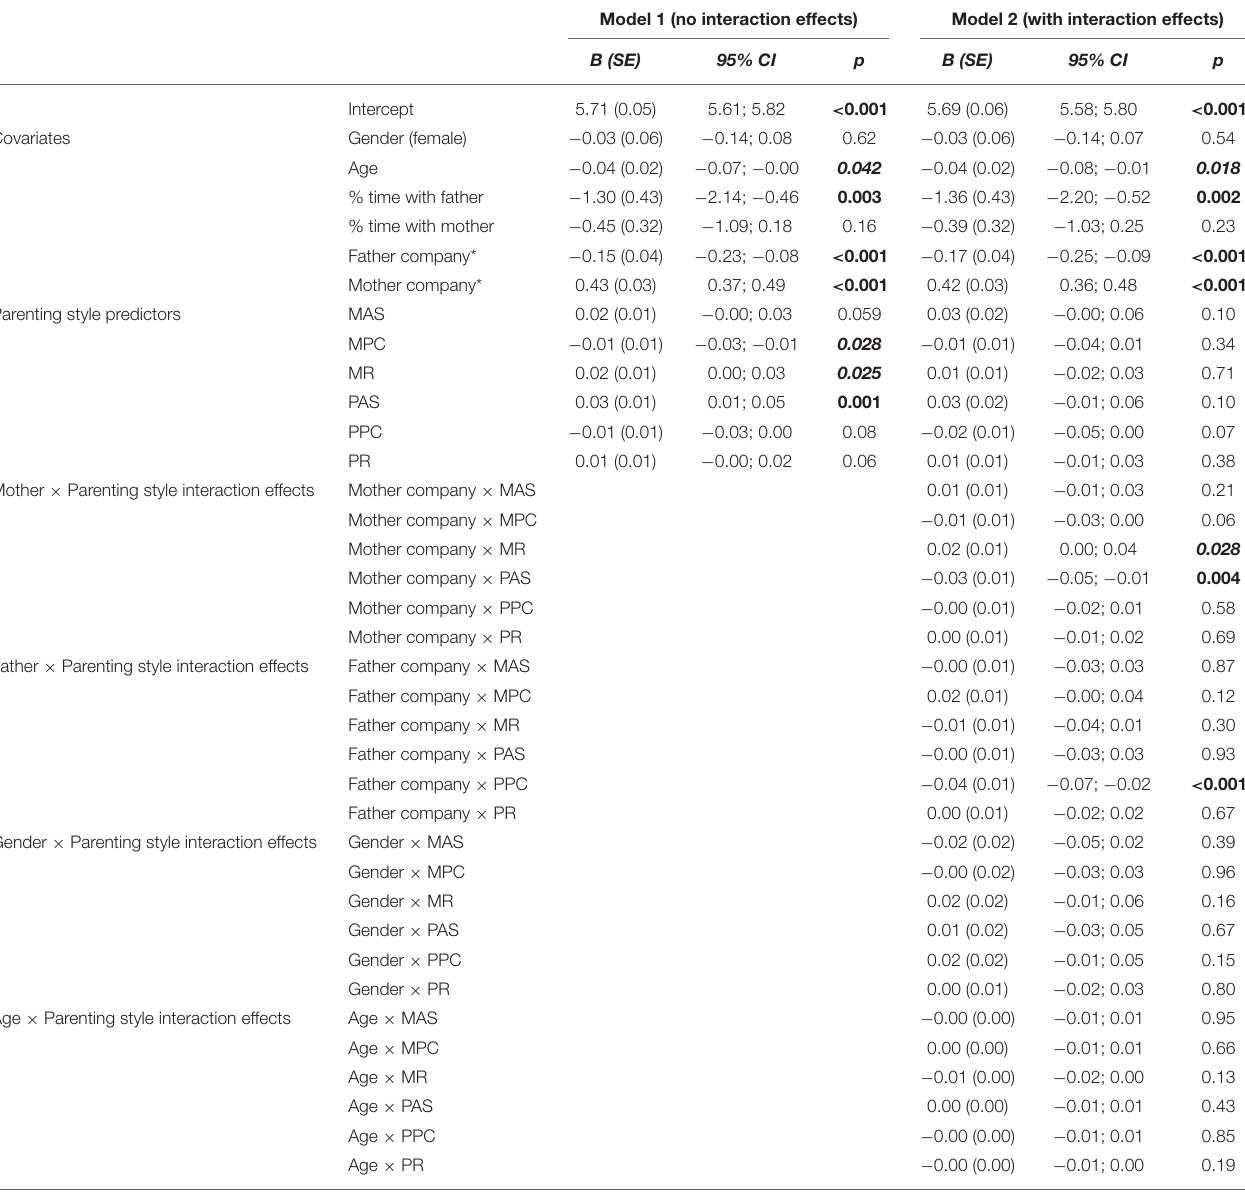
TABLE 3 | Predicting momentary social experience from parenting styles, and from the cross-level interactions between parenting styles and company